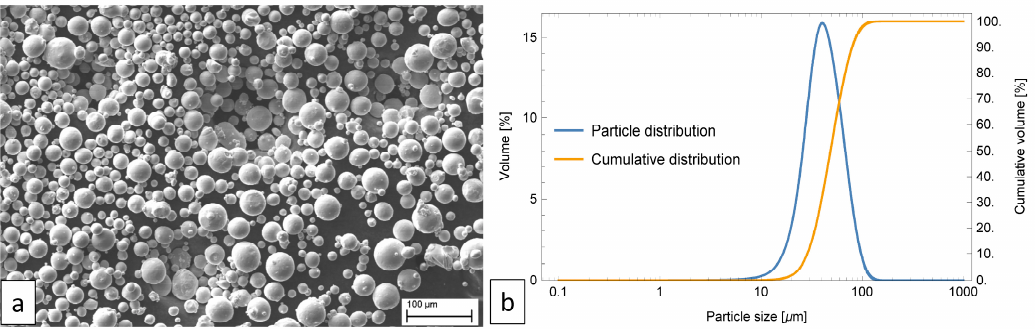
Figure 1. ( a ) SEM image of Ti6Al4V powders; ( b ) granulometry distribution of the powders.